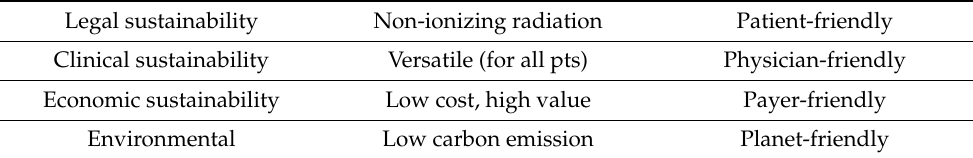
Table 2. The four main features of stress echo in the era of sustainability.